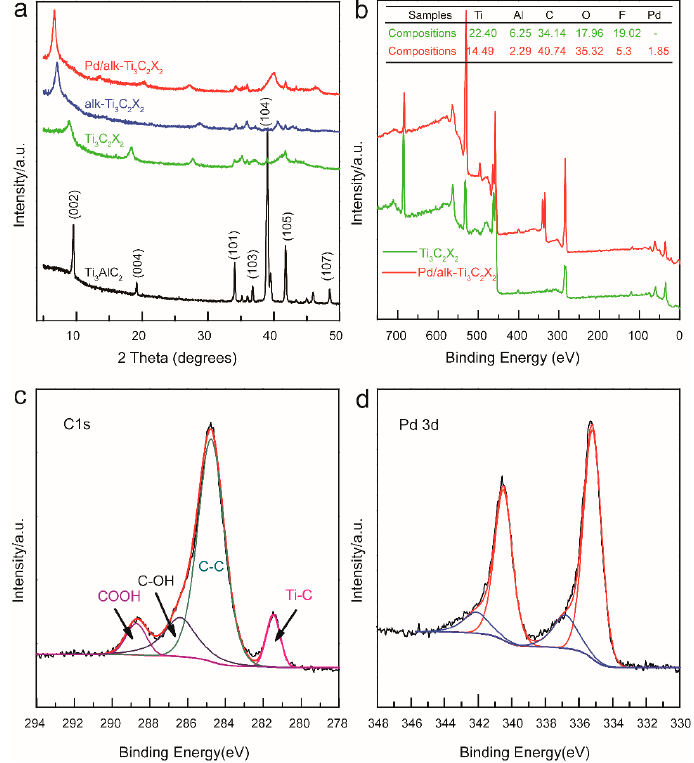
Figure 3. ( a ) XRD patterns of Ti 3 AlC 2 , Ti 3 C 2 X 2 , alk-Ti 3 C 2 X 2 , and Pd/alk-Ti 3 C 2 X 2 . ( b ) XPS survey scans of Ti 3 C 2 X 2 and Pd/alk-Ti 3 C 2 X 2 (Inset is the atomic ratio of the detected elements); ( c , d ) High-resolution XPS spectra of C1s and Pd 3d for Pd/alk-Ti 3 C 2 X 2 .